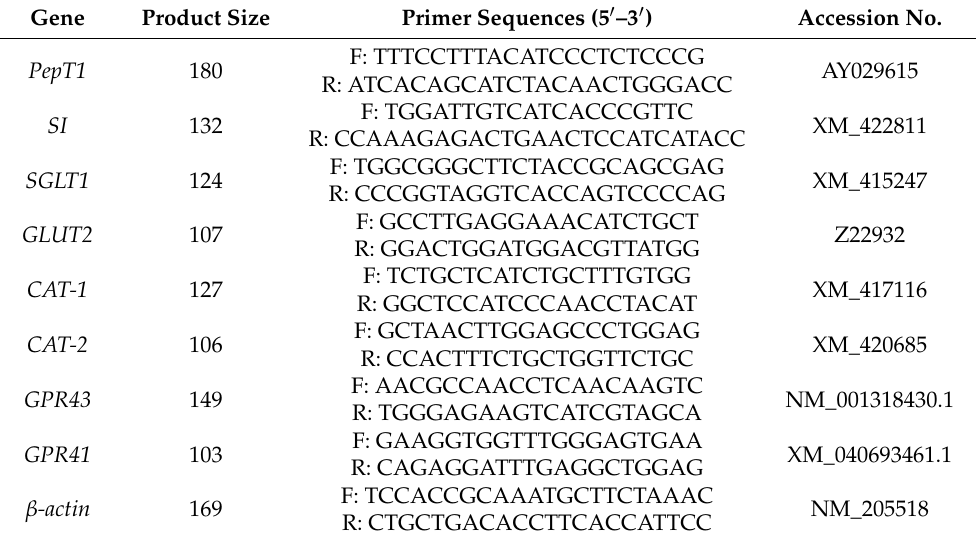
Table 2. Sequences of primers used for